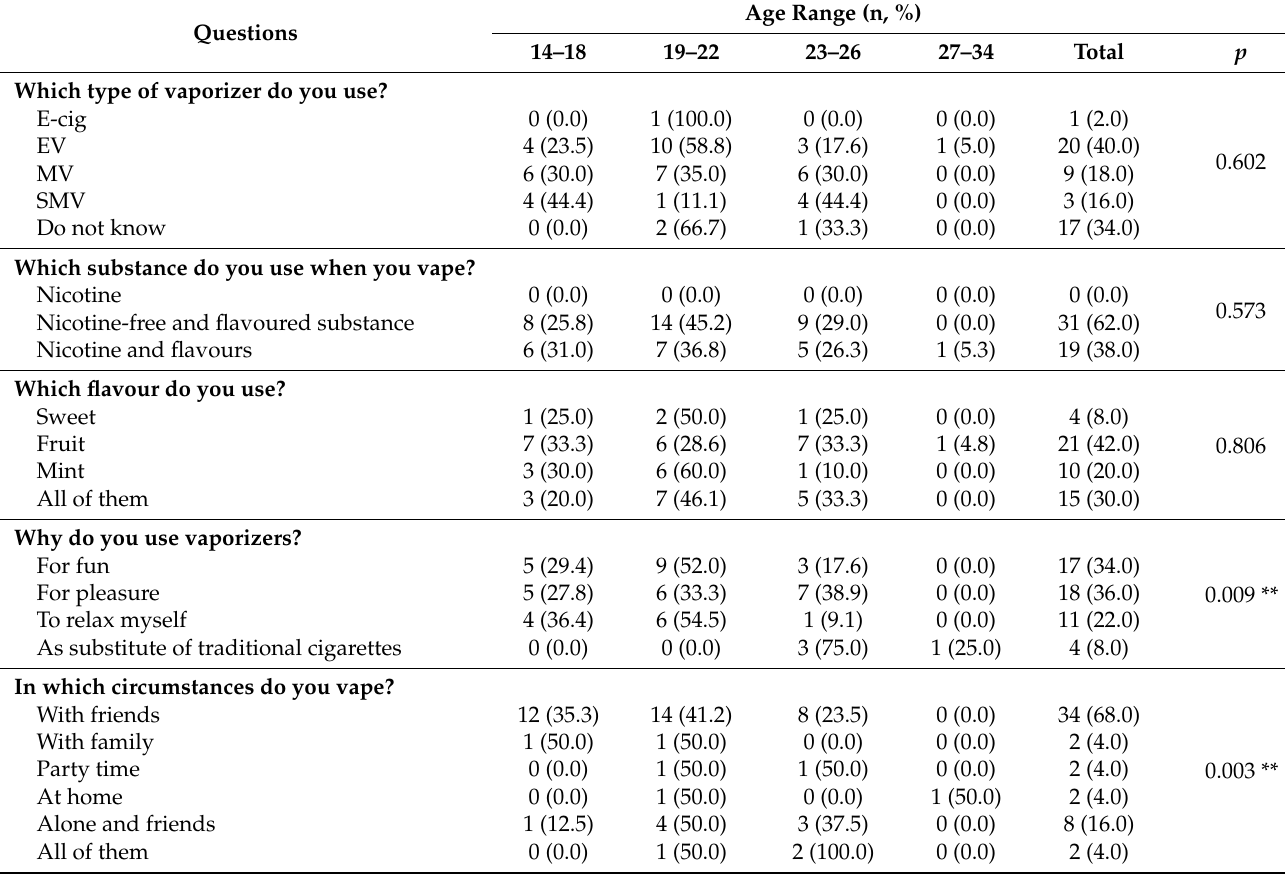
Table 3. Behaviours and characteristics of